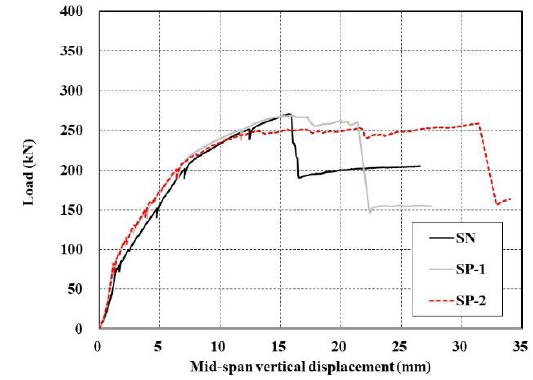
Figure 11. Load-displacement curve for SN and SP series specimens.